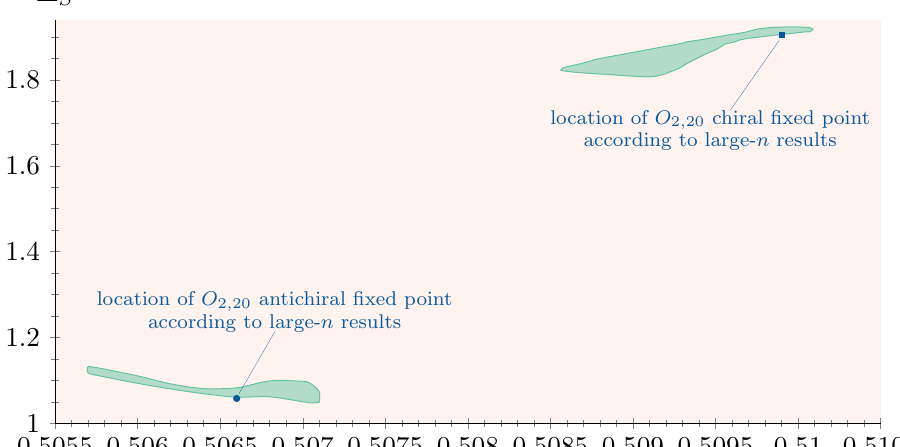
chiral and antichiral fixed points and 2,20 -1)- 2,20